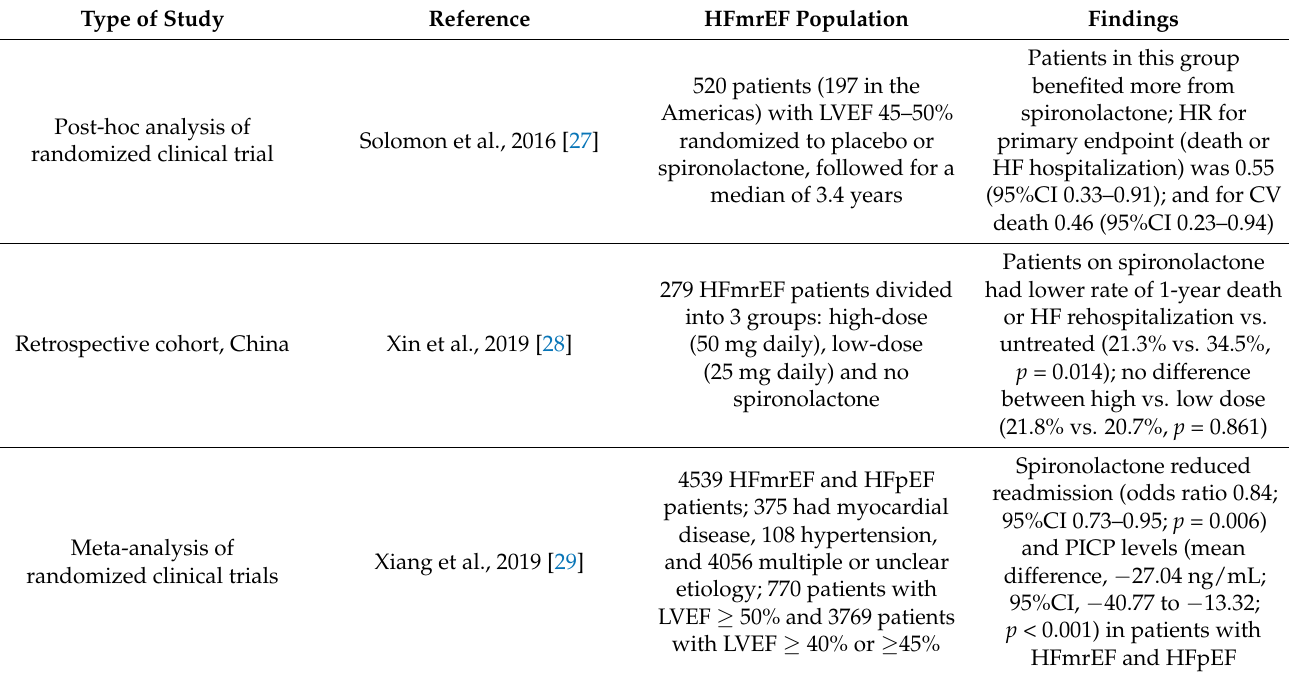
Table 2. Key Studies with Mineralocorticoid Receptor Antagonists in Patients with